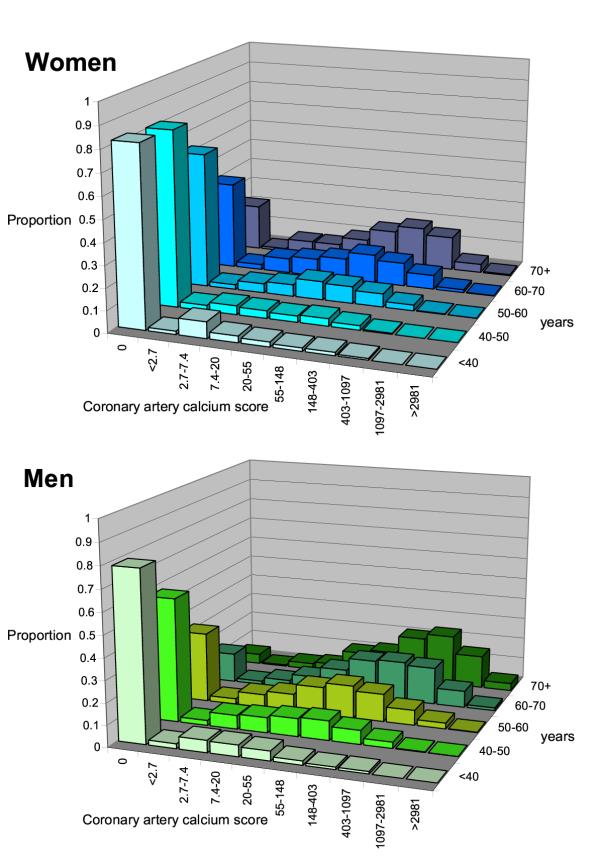
Distribution of coronary artery calcium scores among men and women, on a logarithmic scale, by age. Categories chosen for histograms are evenly spaced on a logarithmic scale, corresponding to Ln(CAC) scores of <1, 1–2, 2–3, 3–4, 4–5, 5–6, 6–7, 7–8, and >8. The first bar represents subjects with no detectable CAC, which corresponds to an undefined Ln(CAC) value. CAC – Coronary artery calcium.